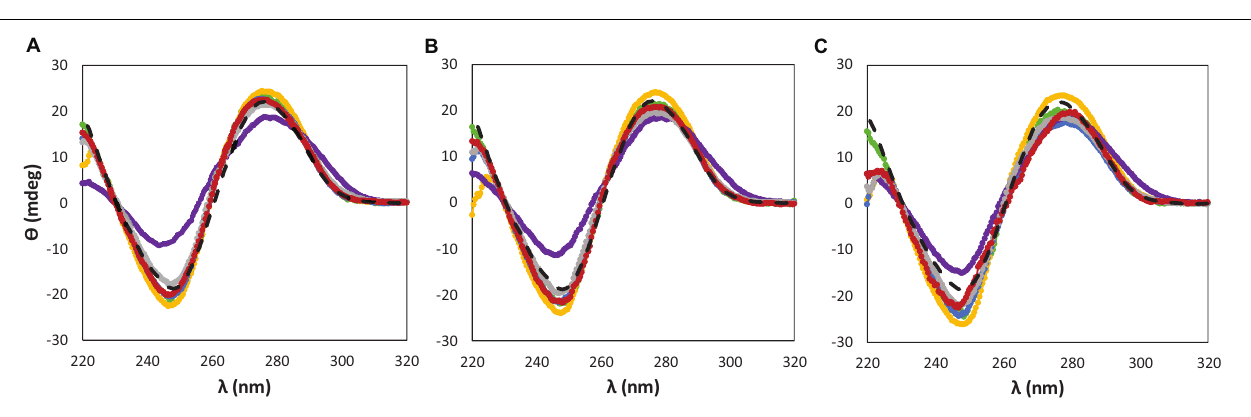
FIGURE 3 | CD spectra regarding the ellipticity, θ , of 0.01 g dm − 3 of β -DNA (from salmon testes) as a function of wavelength, λ , in 10 mM of Tris–HCl buffer (pH ≈ 7.2) aqueous solutions at different concentrations of cholinium-based ILs: (A) 5 wt%; (B) 15 wt%; (C) 30 wt%. ( — ) only buffer; ( • ) [N 111 ( 2 OH ) ]Br; ( • ) [N 111 ( 2 OH ) ]Cl; ( • ) [N 111 ( 2 OH ) ][Ac]; ( • ) non-buffered [N 111 ( 2 OH ) ][DHP]; ( • ) buffered [N 111 ( 2 OH ) ][DHP]; ( • ) [N 111 ( 2 OH )